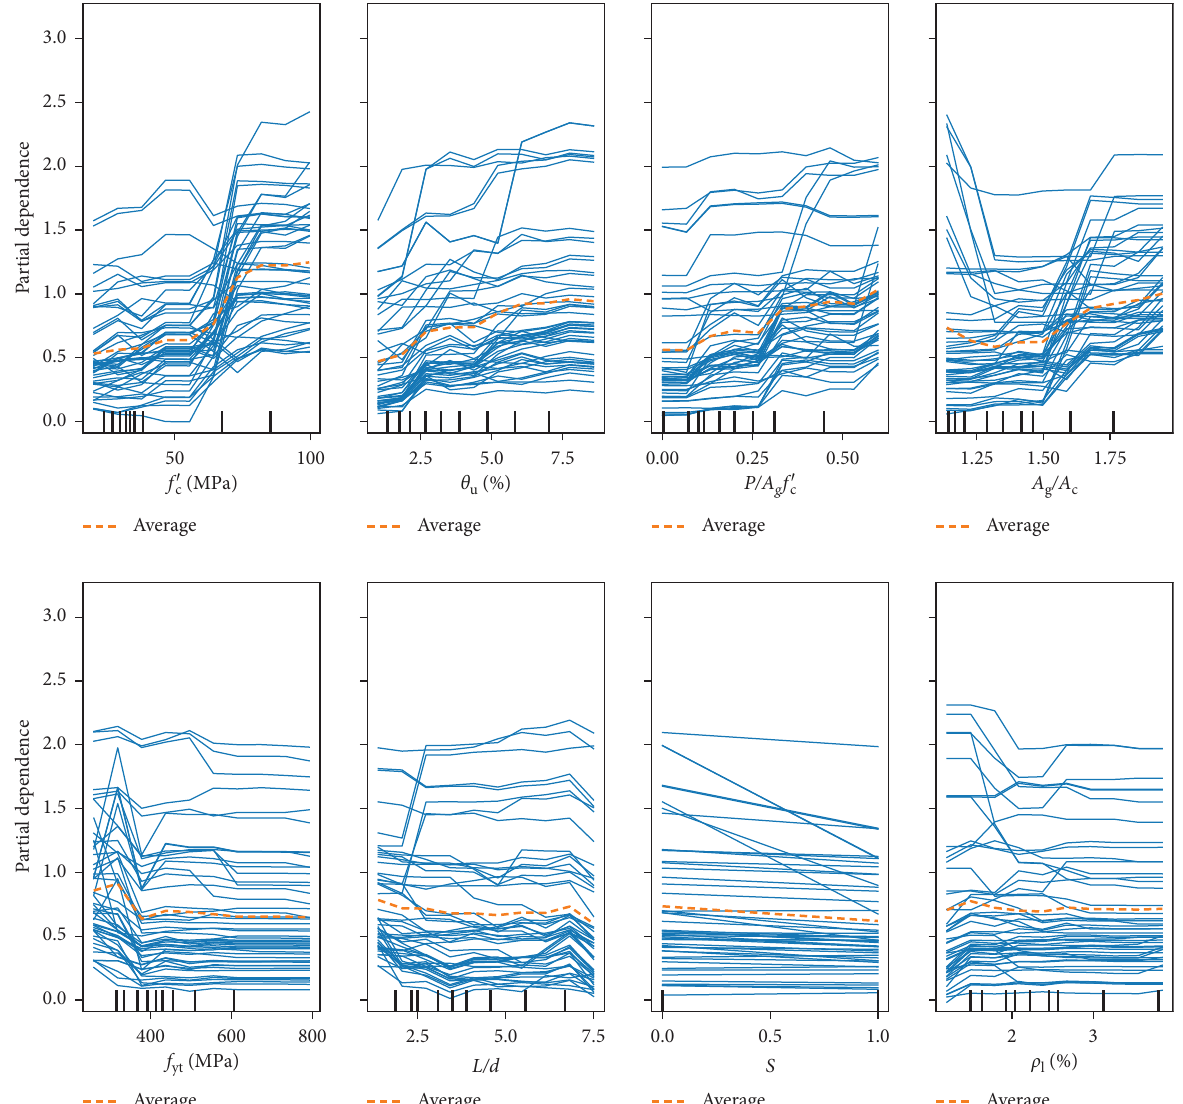
Figure 7: One-way PDPs of transverse reinforcement